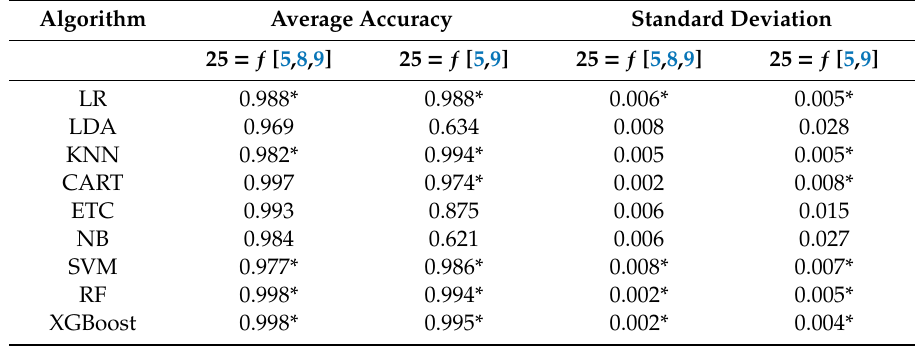
Table 6. Average accuracy—selected environmental data for plant configuration identification. With *: average accuracy defined considering the tuning of hyperparameters.